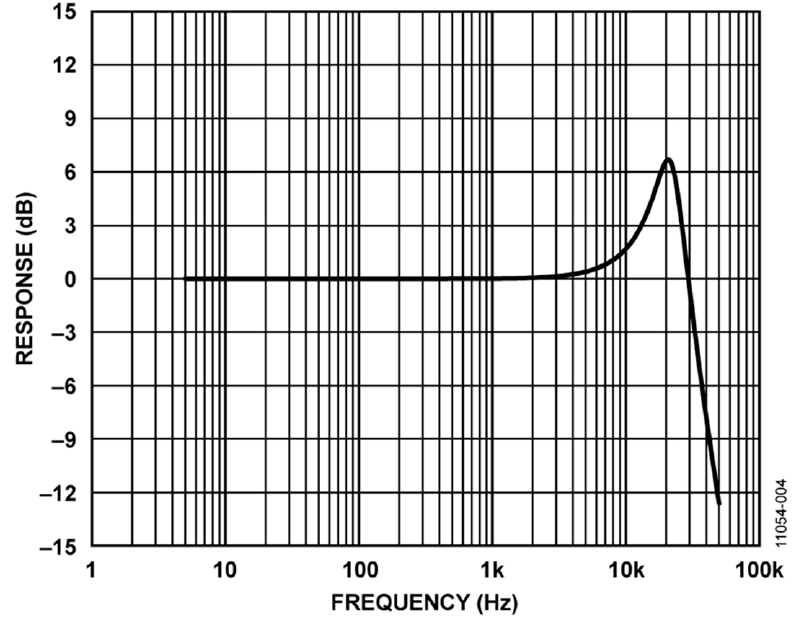
Figure 1. The frequency response of the ADXL001 sensor [16].